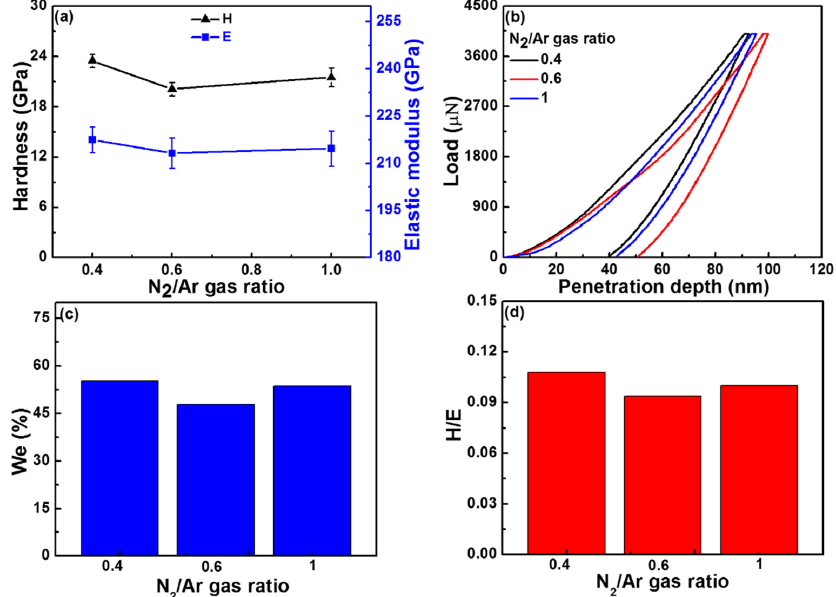
Figure 8. Hardness ( H ) and elastic modulus ( E ) ( a ); load ‐ displacement curves ( b ); elastic recovery ( W e ) ( c ) and H / E value of NbN x >1 coatings deposited at different N 2 /Ar gas ratios with constant − 50 V bias voltage ( d ).